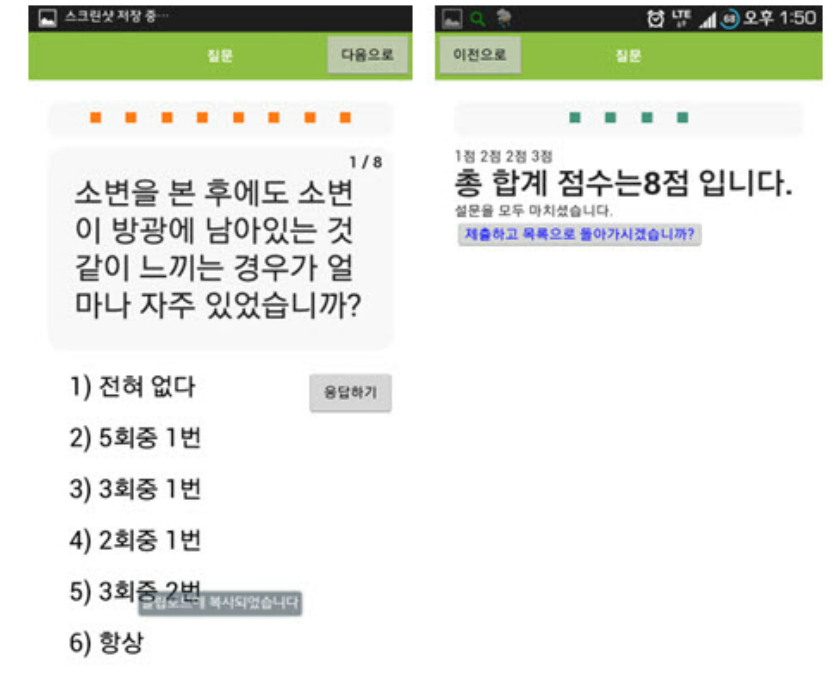
Figure 3. IPSS question 1 and ending screen in the smartphone application. IPSS: International Prostate Symptom Score.